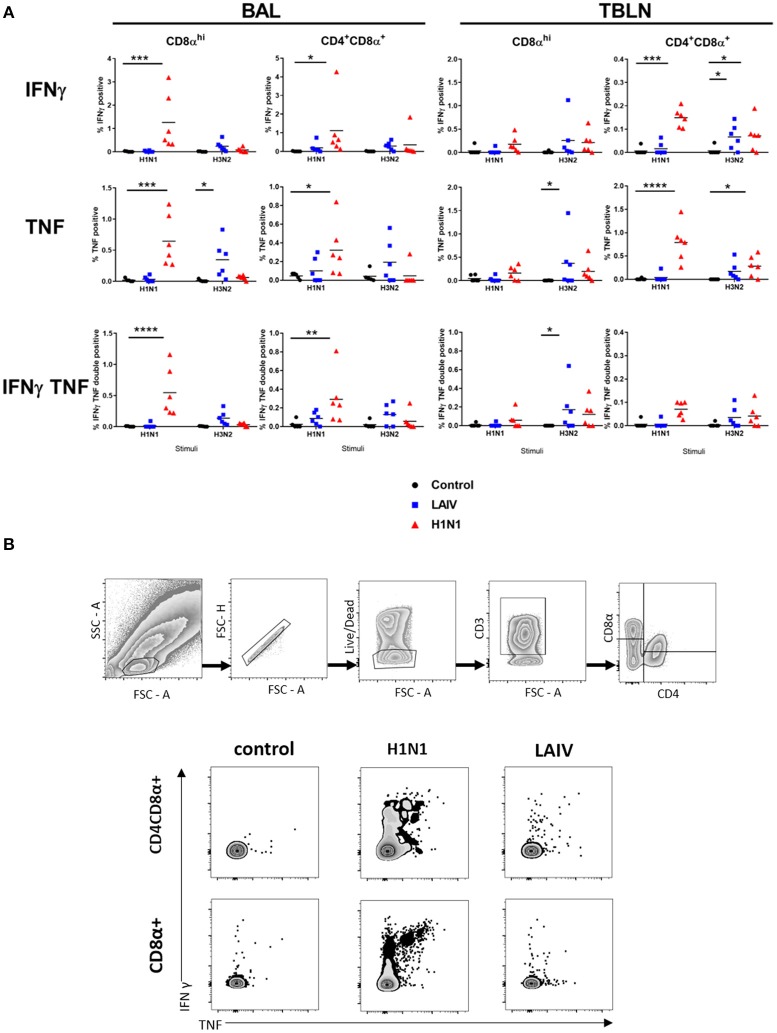
Cytokine producing cells in TBLN and BAL. Pigs were immunized with LAIV or infected with wt H1N1. Controls were untreated. All animals were challenged with wt H1N1 4 weeks after immunization or wt H1N1 pre-exposure and culled 4 days later. Lymphocytes isolated from TBLN and BAL at day 4 post challenge were in vitro stimulated with wt H1N1 or wt H3N2. Flow cytometry was used to quantitate the frequency of IFNγ, IFNγTNF, and TNF positive cells within CD8αhi and CD4CD8α cells in BAL and TBLN. The media only has been subtracted. Each data point represents an individual within the indicated group, and bars represent the mean (A). Gating strategy and representative FACS plots of BAL cells are shown in (B). Data were analyzed using two-way ANOVA with Dunnet's test for multiple comparisons. Asterisks denote significant differences between the indicated groups *p < 0.05, **p < 0.05, ***p < 0.005, ****p < 0.0005.